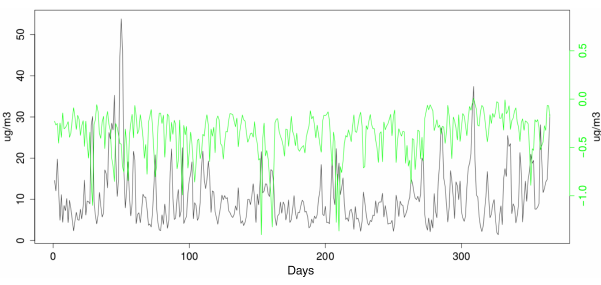
Figure 12. PM 2 . 5 time series. Concentrations averaged over the Dutch and Belgian coasts (area 4) and the negative bias if ship emis- sions were